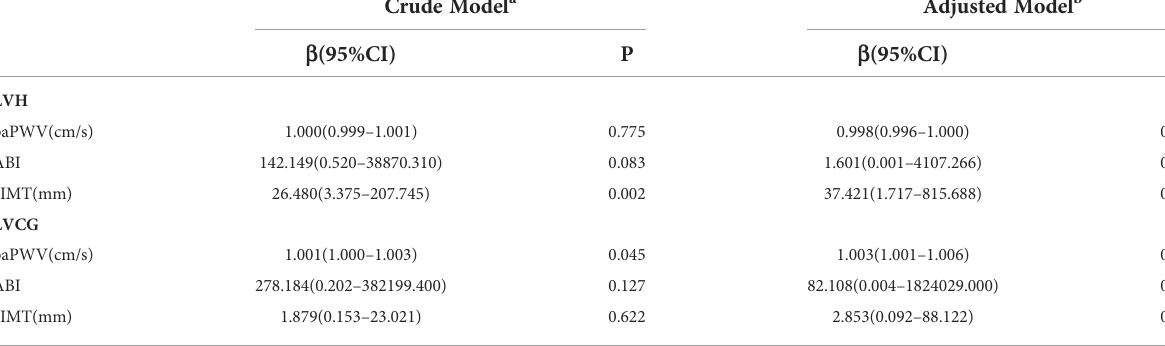
TABLE 4 Logistic regression analysis of LVH and LVCG with vascular